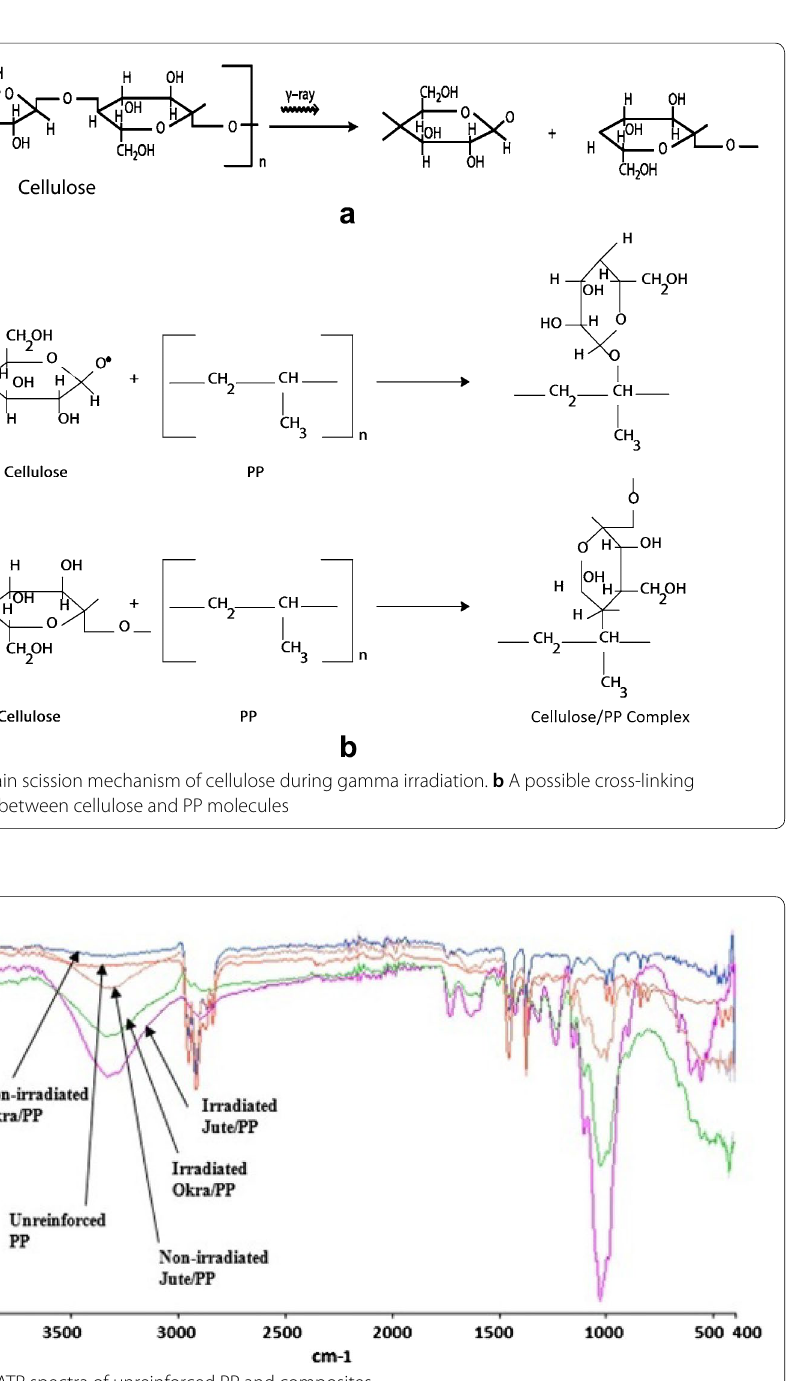
FTIR-ATR Analysis